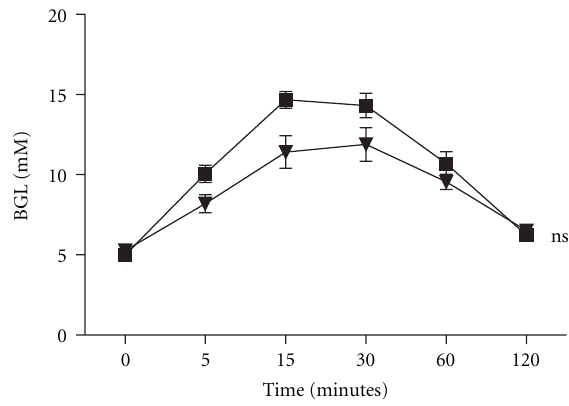
Figure 2: Inhibition of A2B receptor in CD73KO mice increases susceptibility to MLDS-induced diabetes. Diabetes incidence of CD73KO mice treated with either saline (open triangles, n = 6) or the A2BR inhibitor (dose: 0.5 μ g/g body weight (BW), twice daily) (black triangles, n = 6). ∗ P < 0 . 05 versus saline-treated mice.